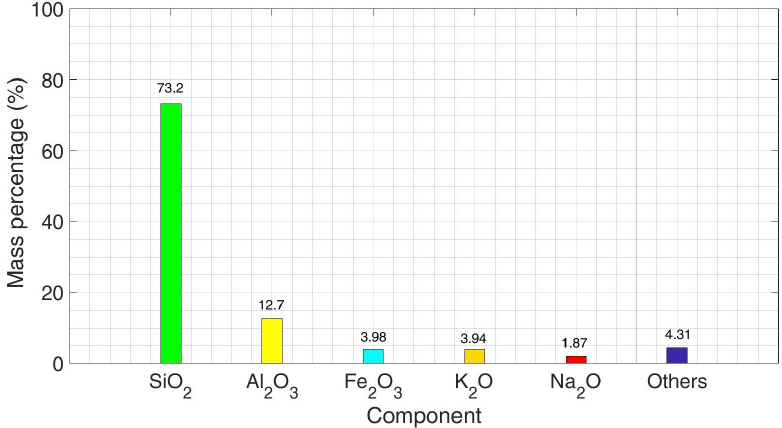
Figure 9. Composition of Saemangeum dredged sand based on X-ray Diffraction Analysis.